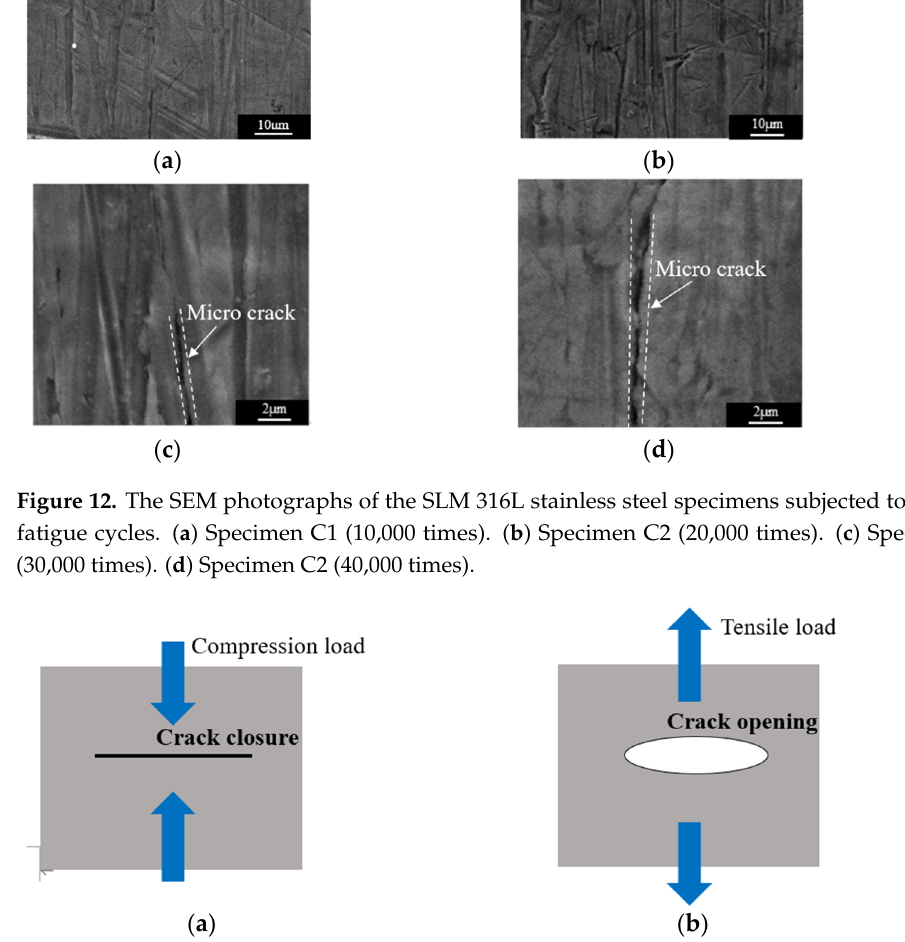
Figure 13. The breathing effect of the crack under a tensile and compressive load of the ultrasonic. ( a ) The crack is compressed and closed. ( b ) The crack is stretched and opened.